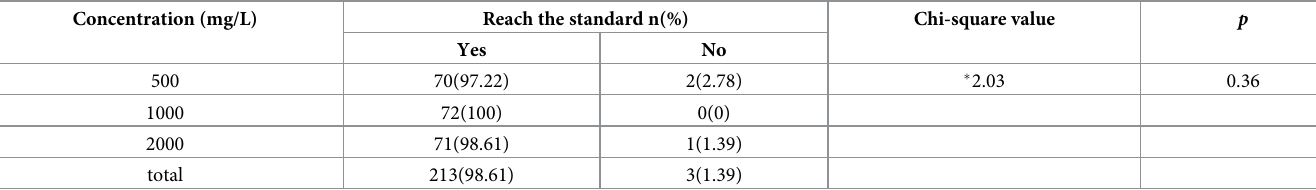
Table 1. Bacterial culture results from different concentrations of high-frequency substances. Concentration (mg/L)